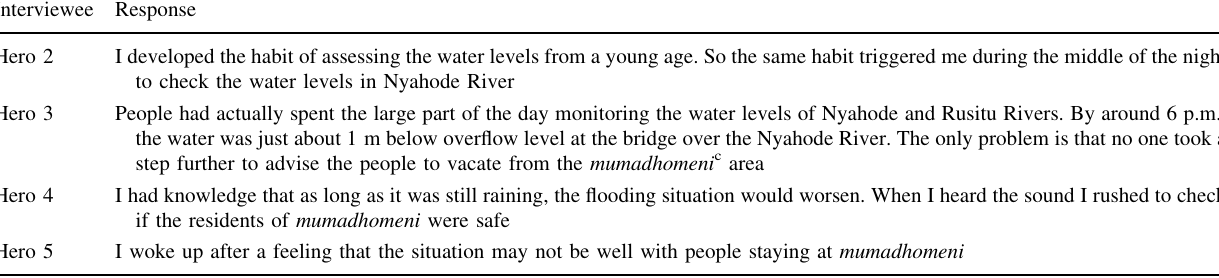
Table 2 Statements by interviewees on local warnings. Source : Primary data 2019 Interviewee